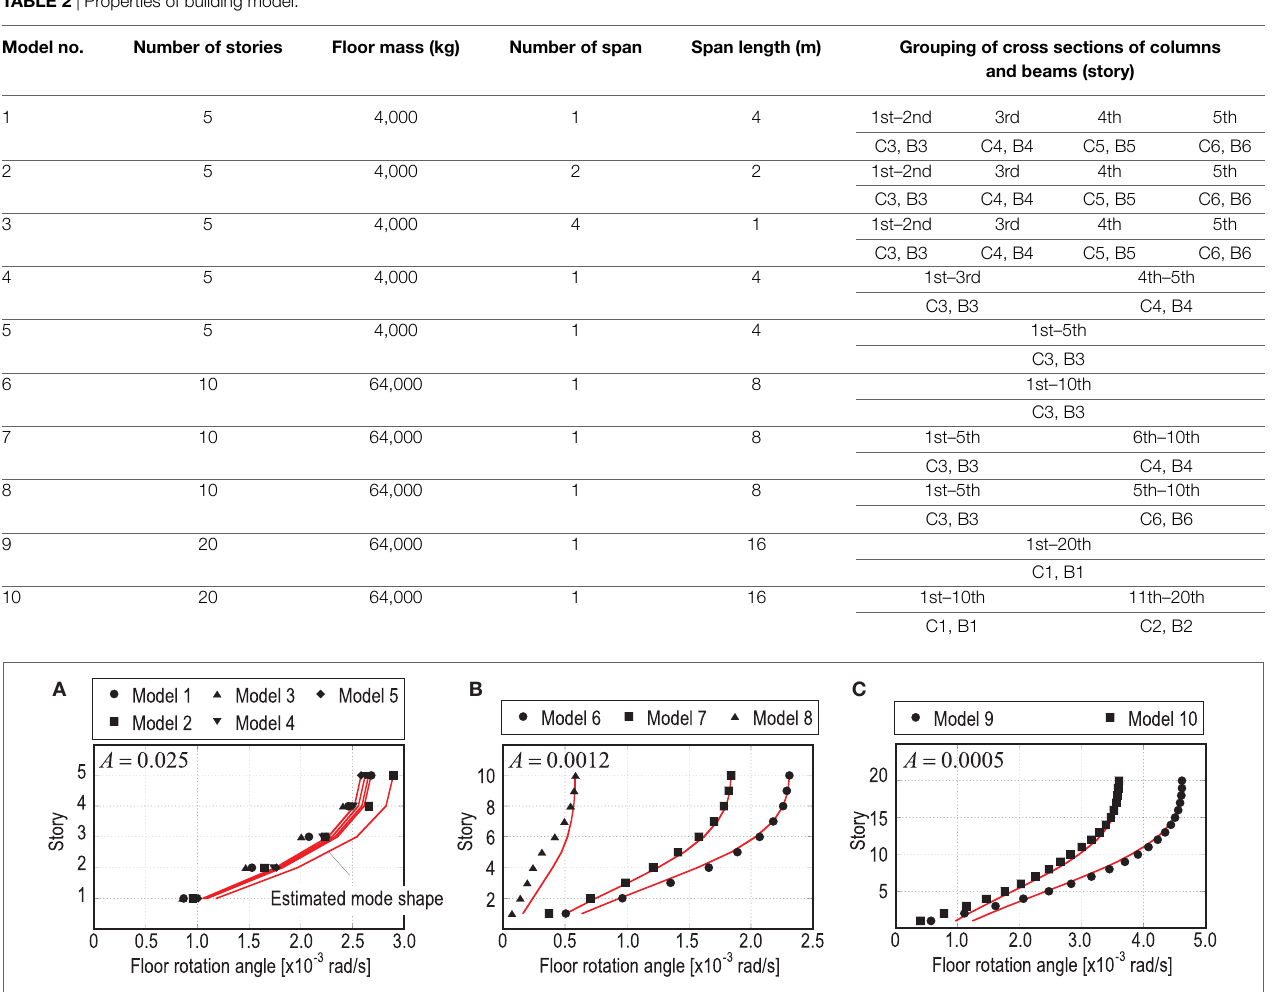
FIGURE 5 | Comparison of identified lowest-mode shape with empirically estimated one, (A) 5-story building, (B) 10-story building, (C) 20-story building.